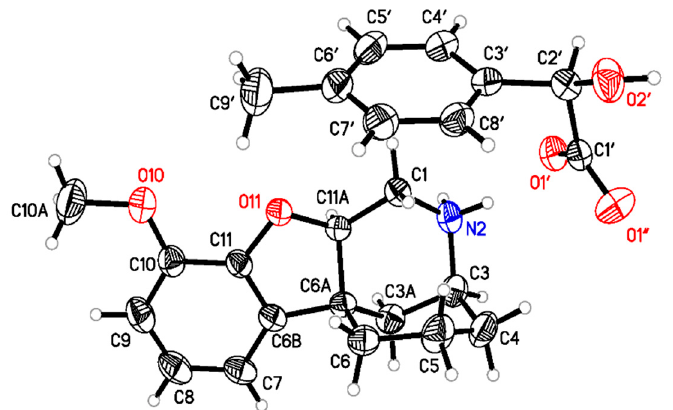
Figure 2. X-ray crystal structure of the ( R )-(-)- p -methylmandelate of (3 S ,6a R ,11a R )-(-)-10-methoxy- 1,3,4,5,6,11a-hexahydro-2 H -3,6a-methano-benzofuro[2,3- c ]azocine (-)-6 . The ellipsoids are shown at the 50% probability level. Crystal data and atomic coordinates can be found in the Supplementary Materials.